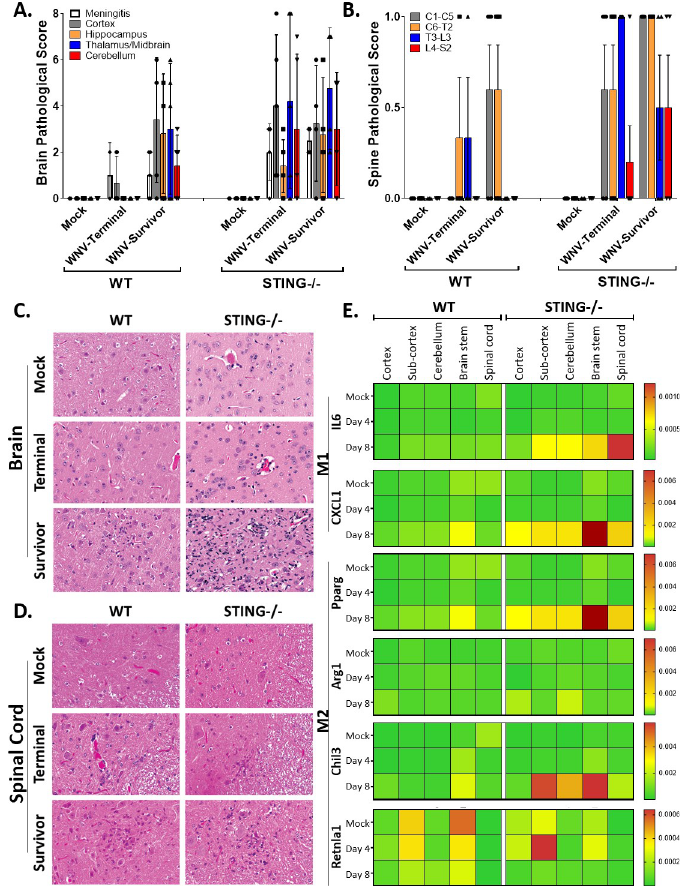
Fig 7. STING is essential in limiting neuropathology and WNV in the CNS. (A-B) Regional analysis of pathology in WT and STING-/- brains (A) and spinal cords (B) in Terminal (mice meeting euthanasia criteria) and Surviving (harvested at study endpoint) mice. n = 3–5 per condition. (C-D) Representative H&E of pathological lesions and cellular infiltration in Brain (C) and Spinal Cord (D). (C) Mock tissues are unremarkable. Terminal mice have minimal lesions, observable in STING-/- as perivascular mononuclear cells and minimal gliosis. For both genotypes, Survivor mice have readable observable neuropathology which is severe in the STING-/- mice with intense gliosis, neuronal degeneration and death and perivascular cuffing with mononuclear cells. In the WT Survivors, there is a mild focus of gliosis and neuronal degeneration. All panels, original magnification 200X. (D) Mock tissues are unremarkable. Terminal mice have minimal lesions, observable as perivascular mononuclear cells. For both genotypes, Survivor mice have readable observable infiltration of mononuclear cells and neuronal degeneration. All panels, original magnification 200X. (E) M1 and M2 gene expression analysis by RT-qPCR. Calculated as relative fold change. n = 3–5 per